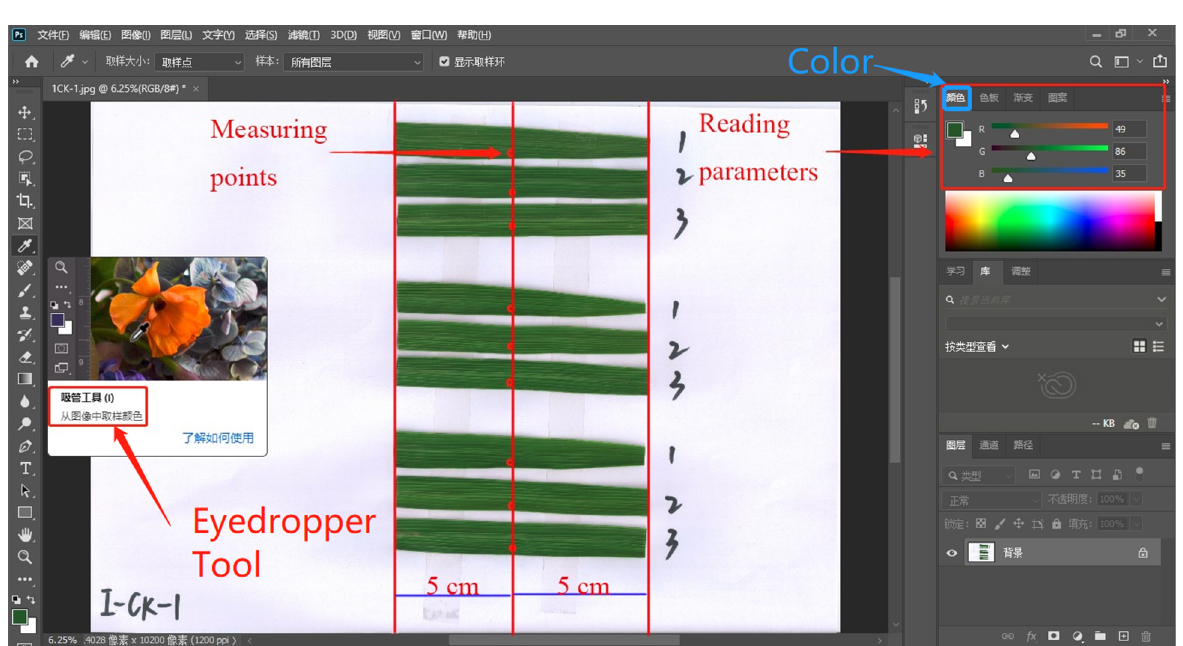
Figure 1. The method used to determine the RGB of rice leaves in Adobe Photoshop 2020.